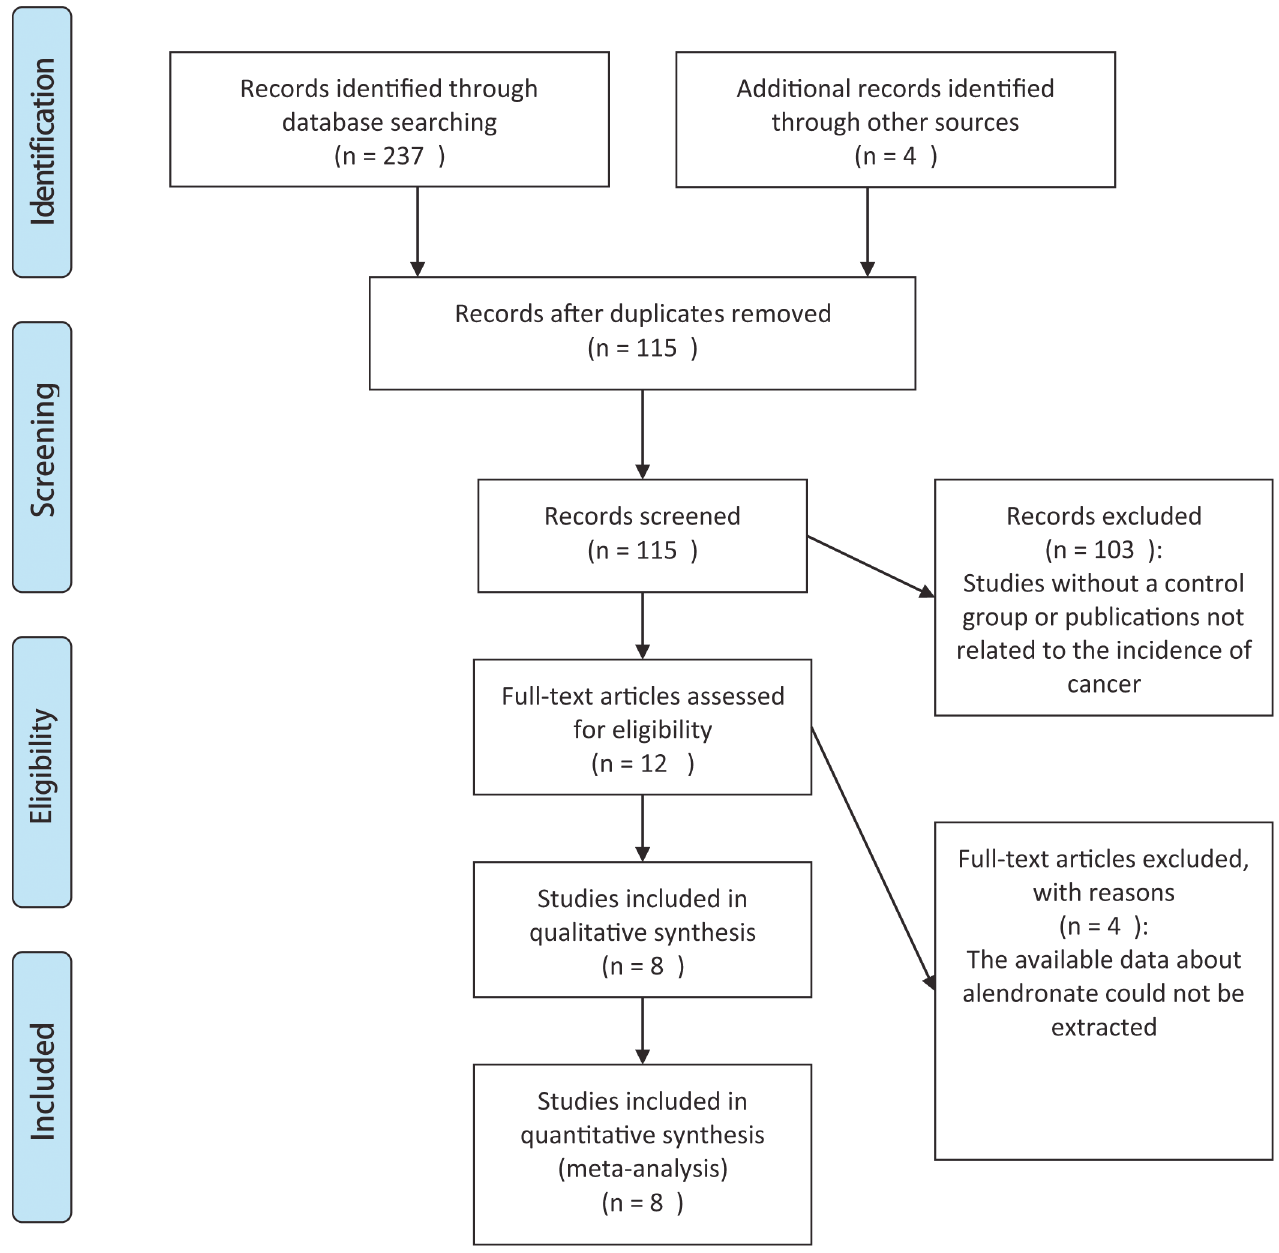
Fig 1. PRISMA flow diagram for study identification and